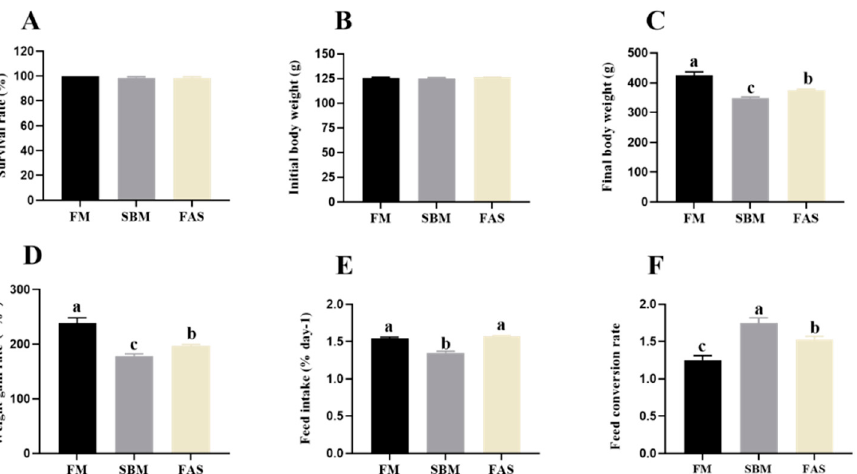
Figure 1. Survival rate ( A ) and growth performance ( B-F ) of Japanese seabass fed diets using soybean meal as fishmeal alternative with or without functional additives. Data are presented as means ± SEM. Bars sharing the same letters are not significantly different ( p > 0.05, n = 4).